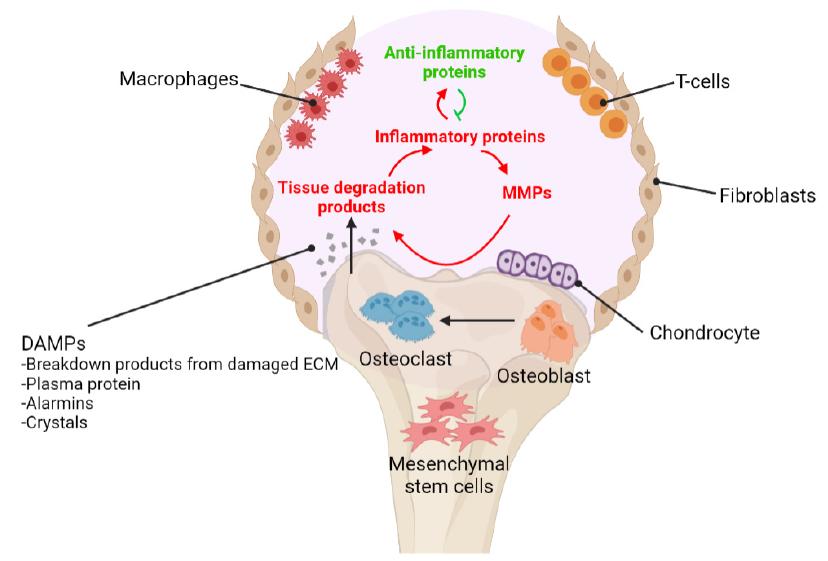
Figure 1. Schematic representation of inflammation process in osteoarthritis . OA is defined by the progressive breakdown of articular cartilage and subchondral bone, and also low-grade inflammation. Following joint injury, cartilage tissue damage causes the production of damage-associated molecular patterns (DAMPs), which include cartilage extracellular matrix (ECM) breakdown products and intracellular alarmins that signal pattern recognition receptors on synovial macrophages, fibroblasts, T cells, or chondrocytes to induce the local release of inflammatory mediators. These activated cells will produce inflammatory factors such as cytokines, chemokines, and catabolic enzymes, either directly or indirectly by inducing proteolytic enzymes which will accelerate cartilage destruction in the progressing osteoarthritis.